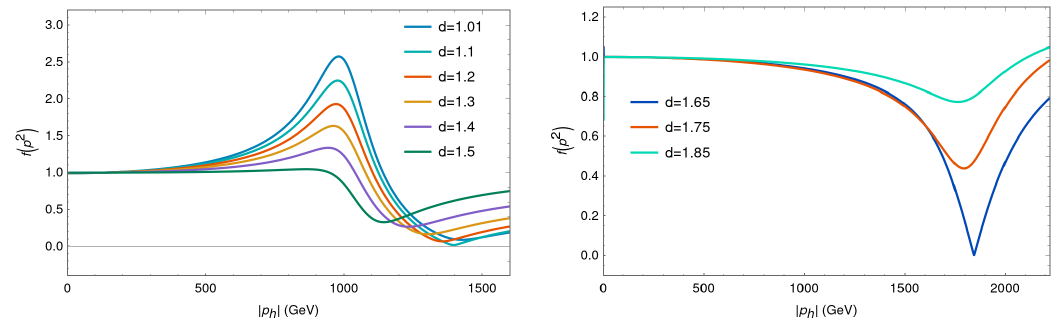
Figure 8 . The Higgs coupling form factor with gauge bosons, (4.19), for various values of d , the dimension of the scalar unparticle operator, and for a 10% width of the